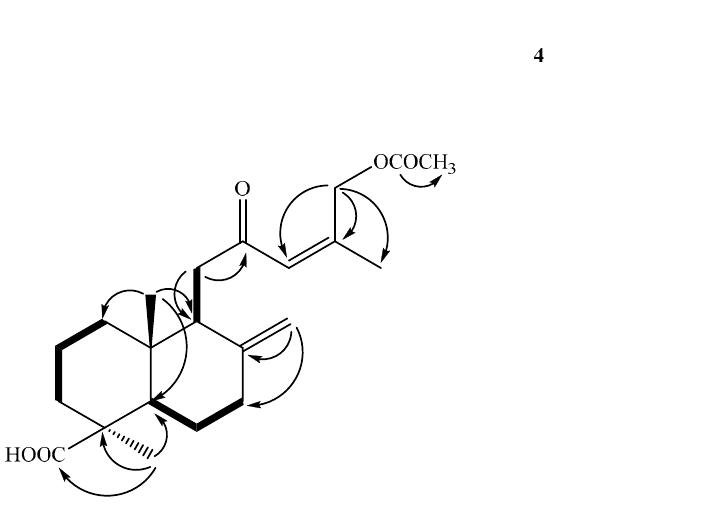
Figure 3. Key COSY ( 1 H ▬ 1 H) and HMBC ( 1 H → 13 C) correlations of Compounds 1 ‒ 5 .